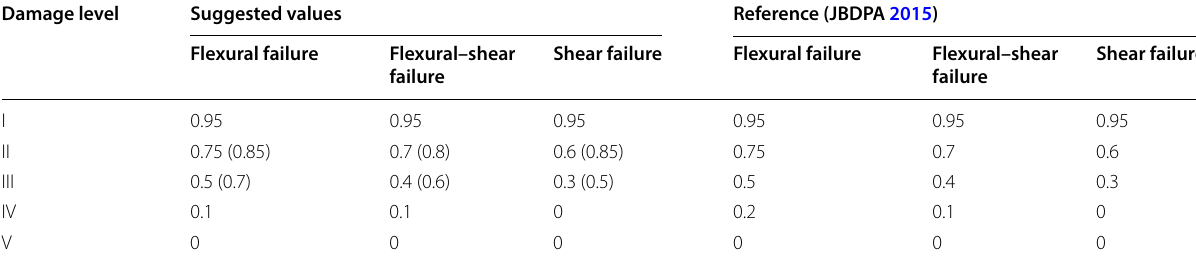
Table 9 Suggested reduction factors of energy dissipation capacity for RC column members.